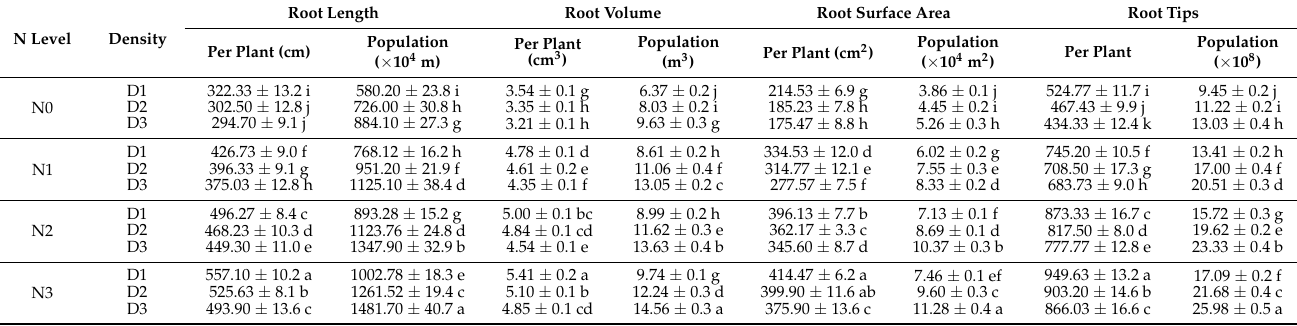
Note: The values in the table were the average of data in 2018 and 2019. Means ± SD followed by different letters in the same column indicated a significant difference ( p < 0.05). Four N fertilization levels—N0: 0 kg ha − 1 ; N1: 120 kg ha − 1 ; N2: 180 kg ha − 1 ; N3: 240 kg ha − 1 . Three plant densities—D1: 180 × 10 4 basic seedlings ha − 1 ; D2: 240 × 10 4 basic seedlings ha − 1 ; D3: 300 × 10 4 basic seedlings ha − 1 . RL: root length; RV: root volume; RSA: root surface area; RT: root